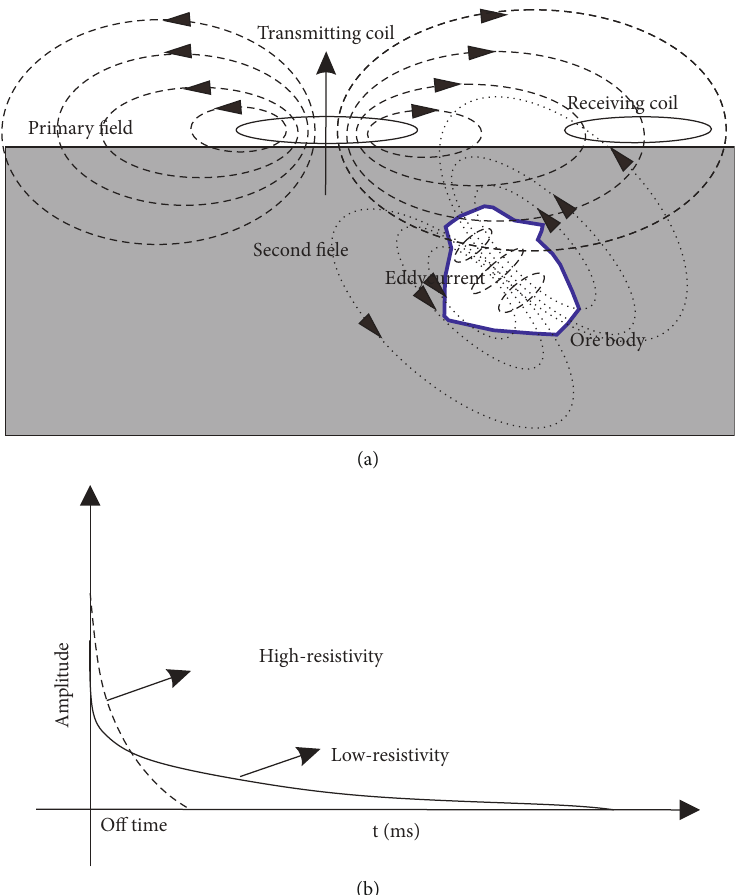
Figure 12: Theory of transient electromagnetic method. (a) Basic principles of ground TEM and (b) response